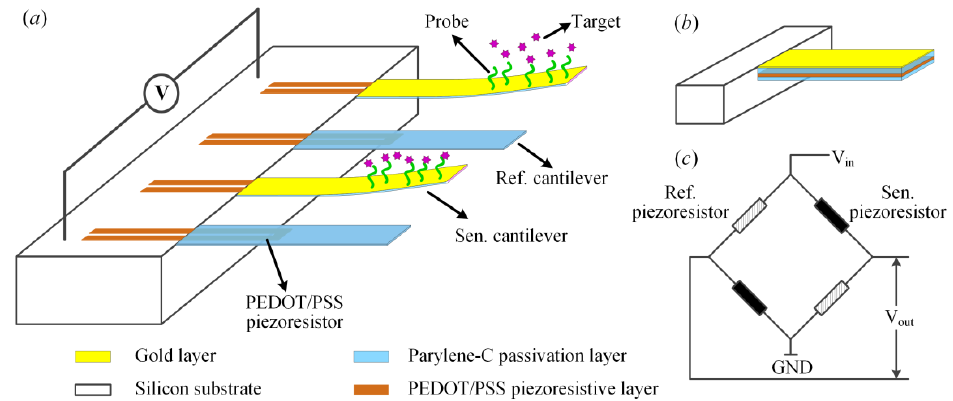
Figure 1. The schematics of ( a ) a polymeric micro-cantilever-based sensor; ( b ) a sensing piezoresistive micro-cantilever based on PEDOT/PSS; and ( c ) arrangement of two pairs of polymeric micro-cantilevers as a Wheatstone bridge for signal readout. The length, width, and thickness of polymeric micro-cantilever are 150, 75, and 2 μm, respectively. The leg dimensions of PEDOT/PSS based piezoresistor are 80 × 8 μm.